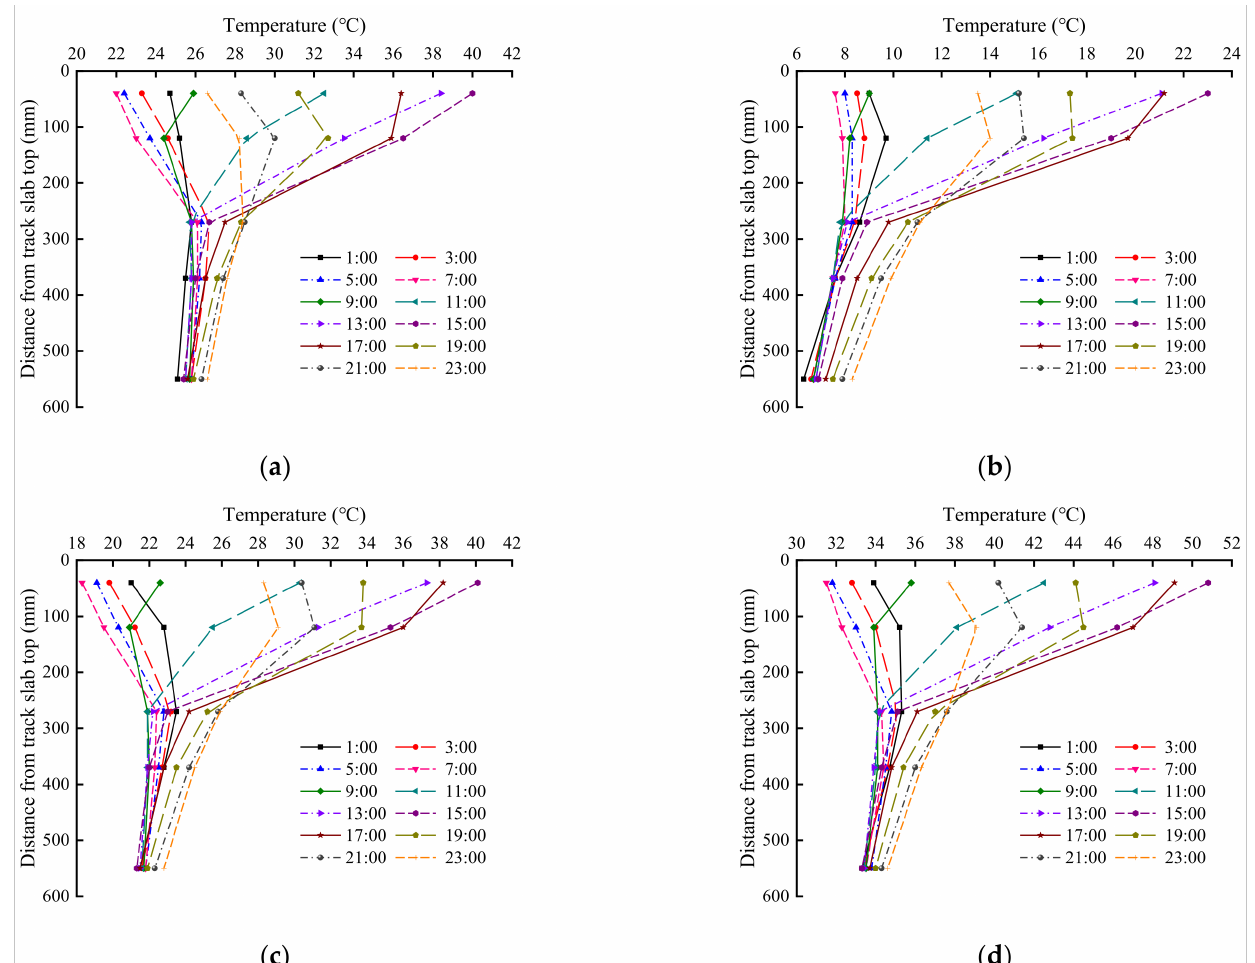
Figure 6. Daily change of vertical temperature of ballastless track (Section II): ( a ) autumn; ( b ) winter; ( c ) spring; ( d )